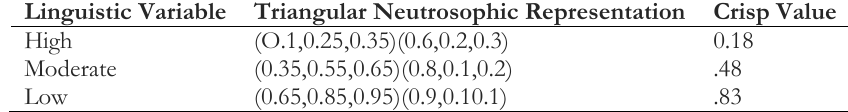
Table 2. Quantification of linguistic